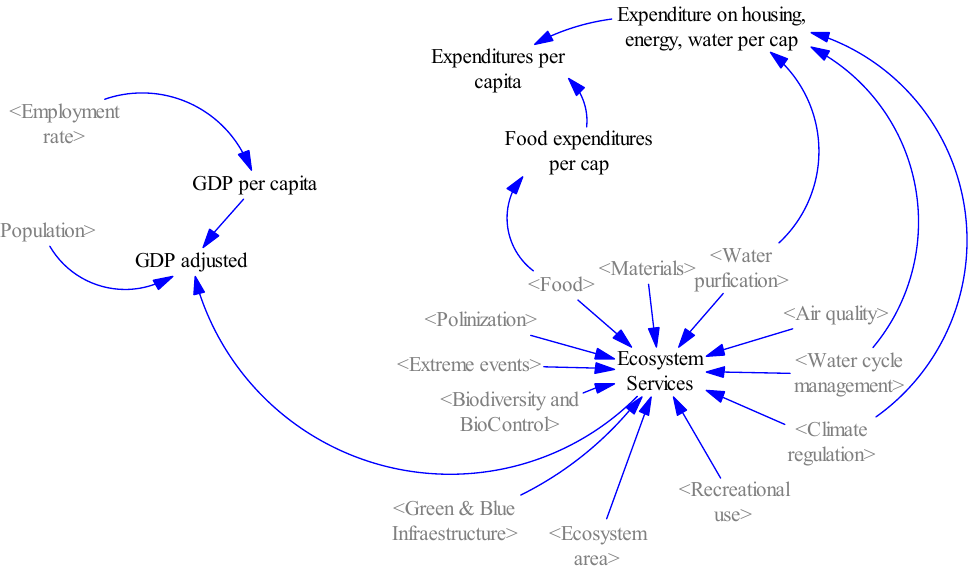
Figure 8. Economic system (own elaboration).